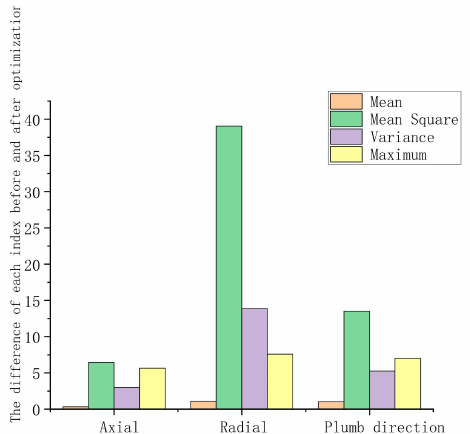
Figure 15. Comparison of time domain data difference in all directions of bearing before and after vibration reduction